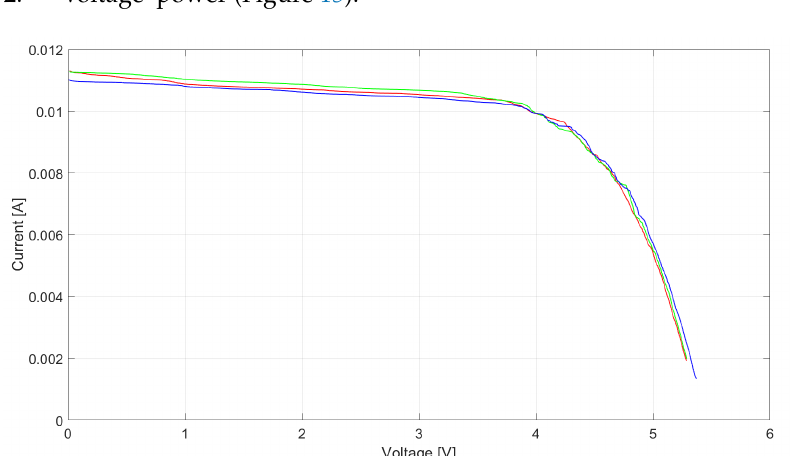
Figure 14. Voltage–current characteristics from 3 measurements of the solar